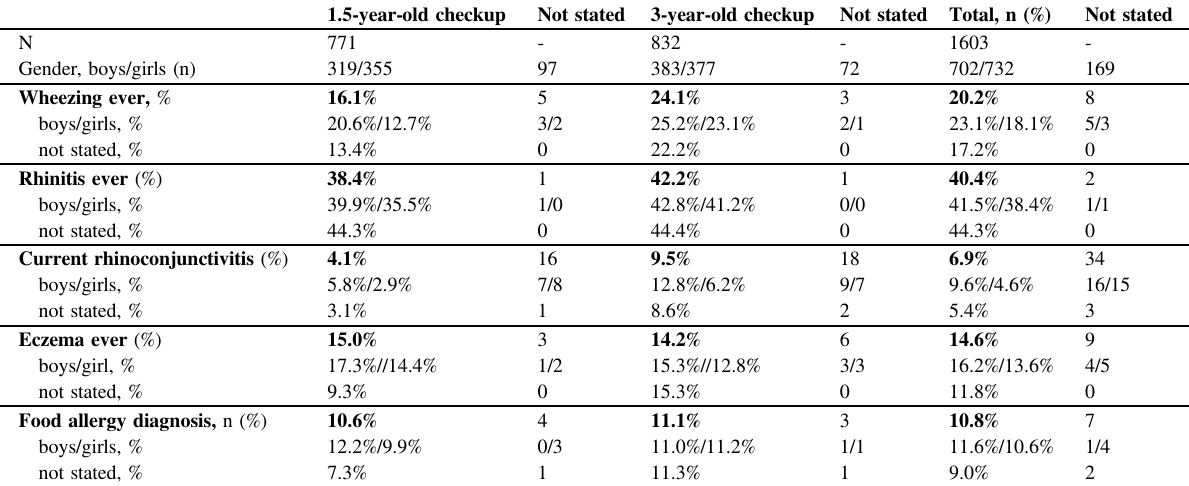
Table 1 Characteristics of the children: prevalence of allergic